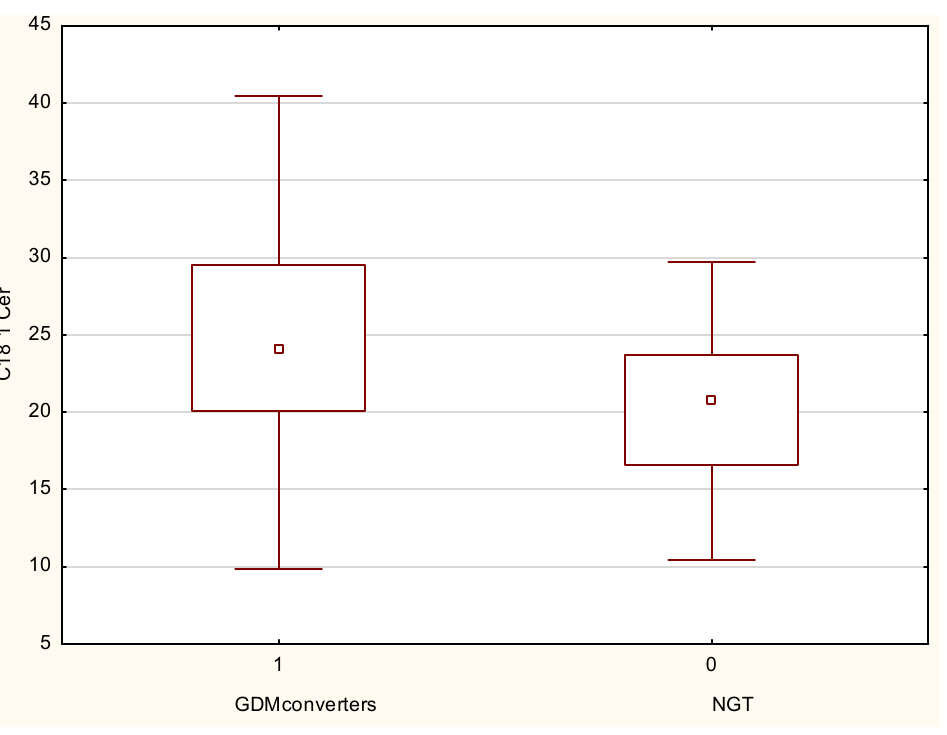
Figure 1. Serum C18:1-Cer concentrations measured in the first trimester of pregnancy. Data are shown as medians and interquartile range. Youdena index = 0.34 Suggested cut off point: 23.86